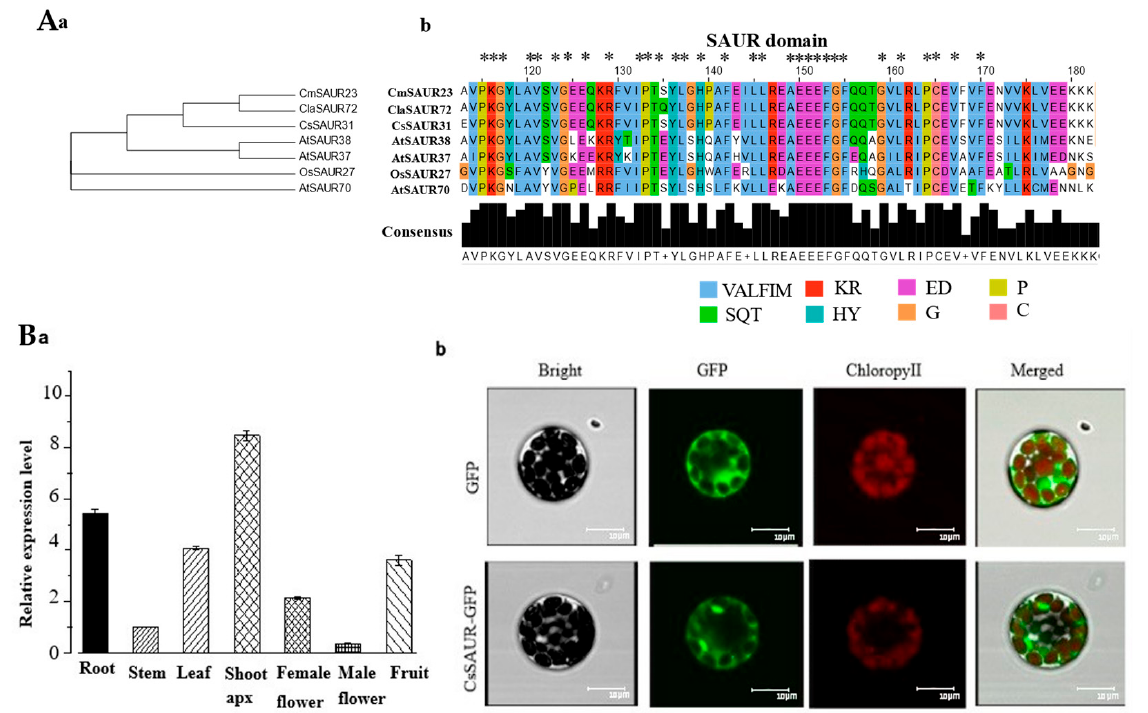
Figure 6. Sequence alignment, tissue expression, and subcellular localization analyses of CsSAUR31. ( A ) CsSAUR31 phylogenetic tree and sequence alignment. ( a ) Phylogenetic tree of CsSAUR31 and other SAUR proteins; ( b ) CsSAUR31 alignment with other SAUR proteins. ( B ) ( a ) CsSAUR31 expression in different tissues; ( b ) CsSAUR31 subcellular localization. The amino acid residues at SAUR domain (about 60 amino acid residues) were labeled in different color. Asterisk (*) indicated highly conserved amino acid residues positions.